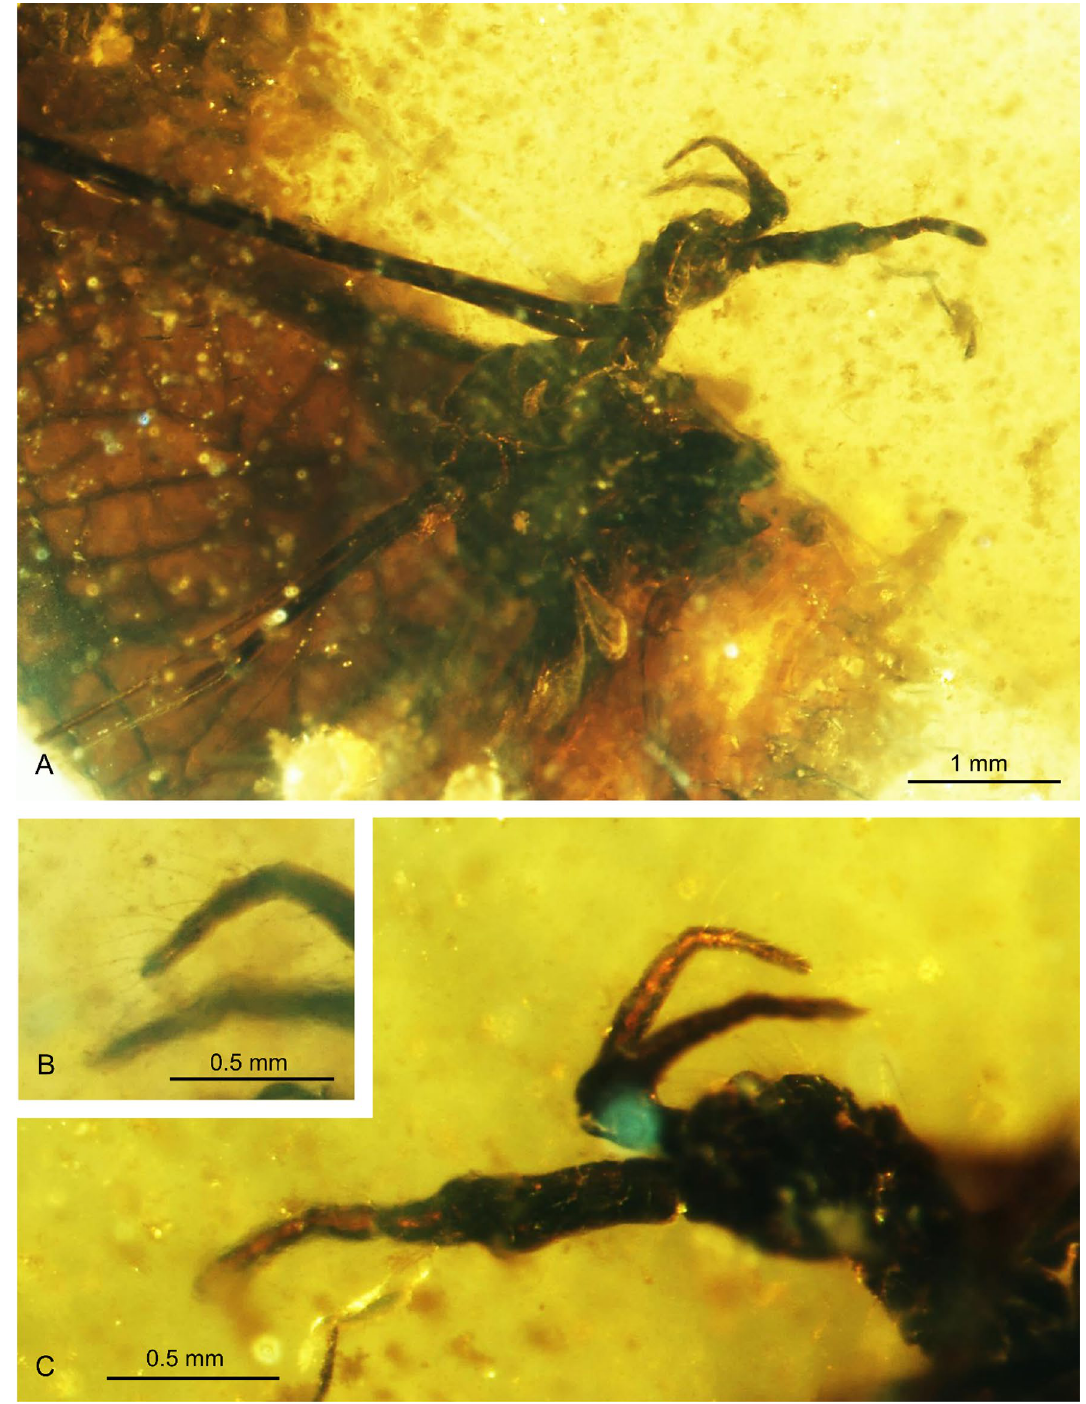
Figure 4. Helius hispanicus sp. nov. No. MCNA 9946 (sex undefinied), holotype. ( A ) fore part of the body (lateral view); ( B ) last palpomeres; ( C ) head (lateral view); Abbreviation of head (h): as in Fig.